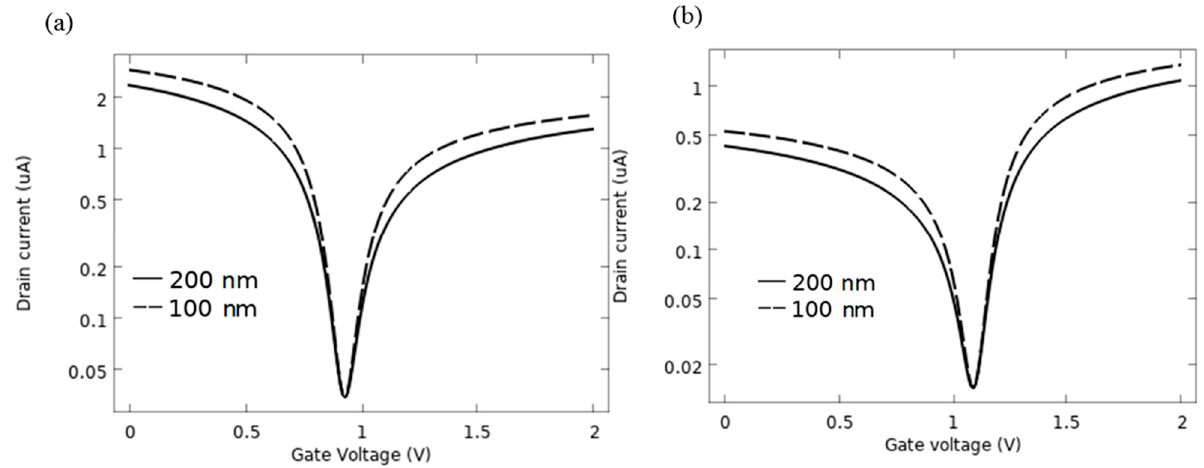
Figure 12. I–V characteristics as a function of dielectric layer thickness ( a ) AlP-GFET ( b ) Pd-GFET.